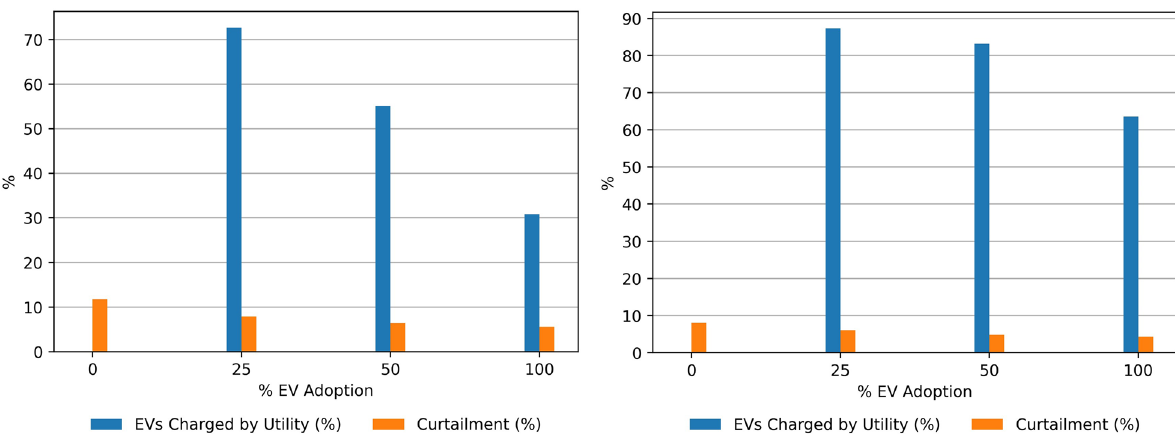
Fig. 12 Comparison between curtailment and percent of electric vehicle demand shifted via UCC as electric vehicle penetration increases for a January (left) and b July (right) for the solar-wind